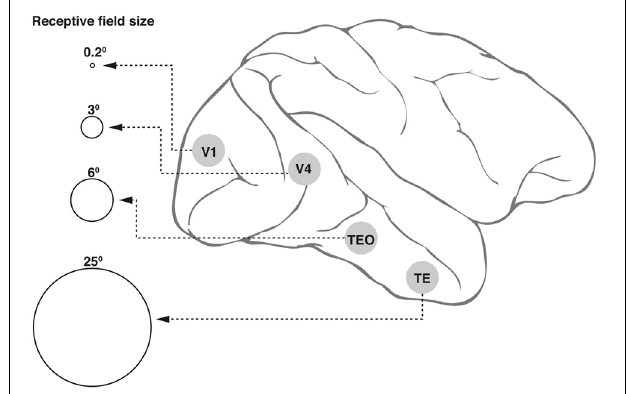
FIGURE 1 | Receptive field (RF) sizes along the ventral cortical stream in the primate. While the degree of complexity of processing may increase, the RF size at any one eccentricity also increases dramatically along the various cortical areas from V1 into the temporal pole. The circles shown in the figure are not drawn to scale, but the numbers above the circles indicate approximate relative sizes of the RF